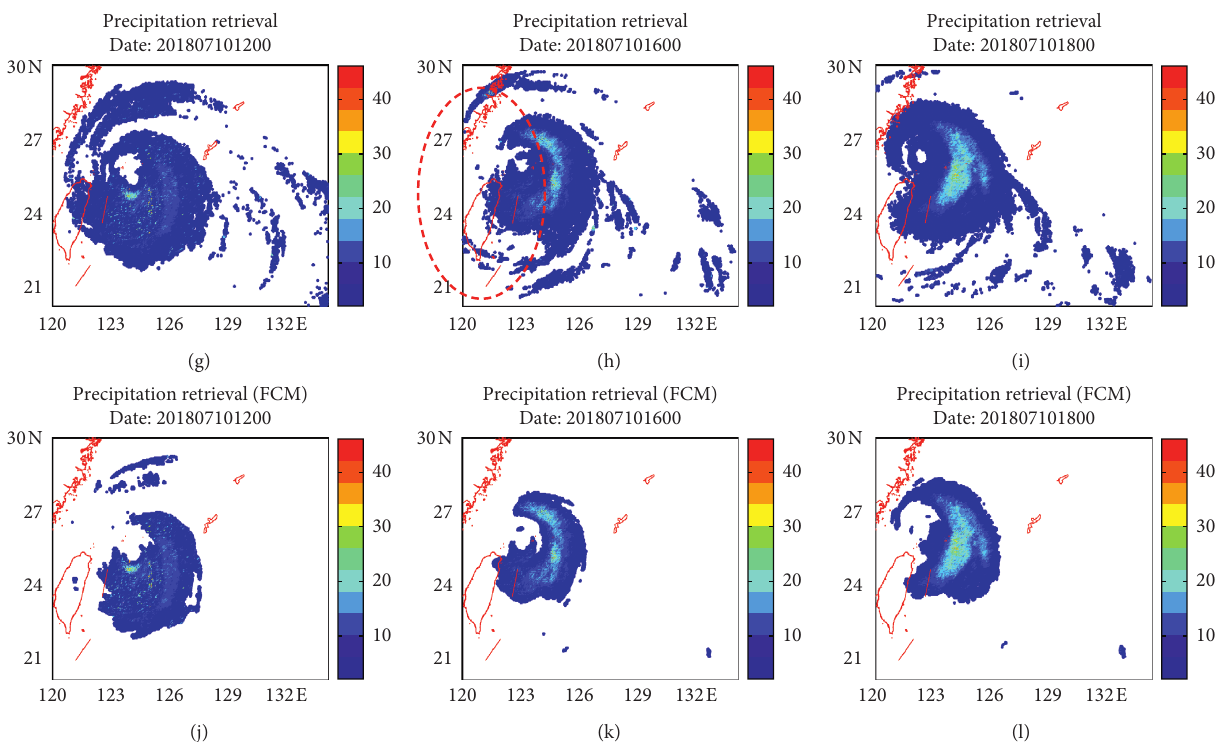
Figure 4: Precipitation retrieval of AGRI based on the SLLE method (a, b, c, g, h, i) and the dominant cloud system membership degree of FCM (d, e, f, j, k, l). Table 1: Comparison of AGRI retrieval precipitation and GPM during Typhoon